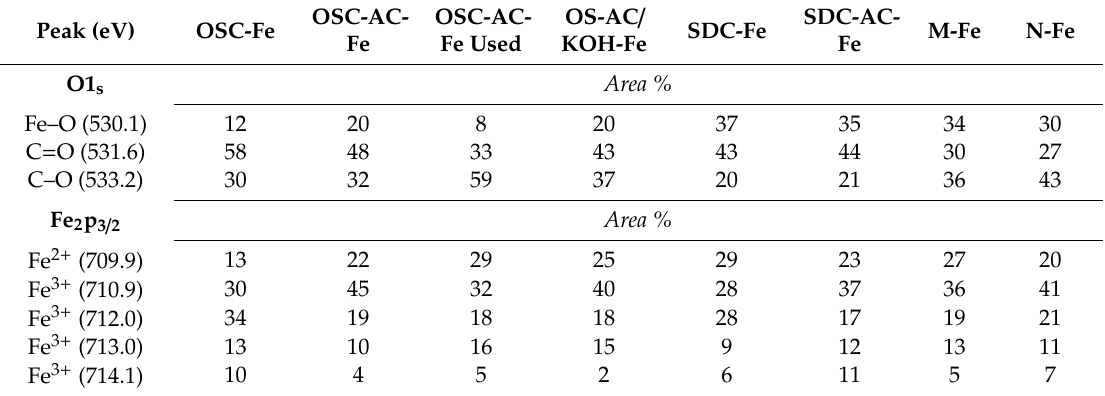
Table 5. Distribution of oxygen and iron species on the catalysts’